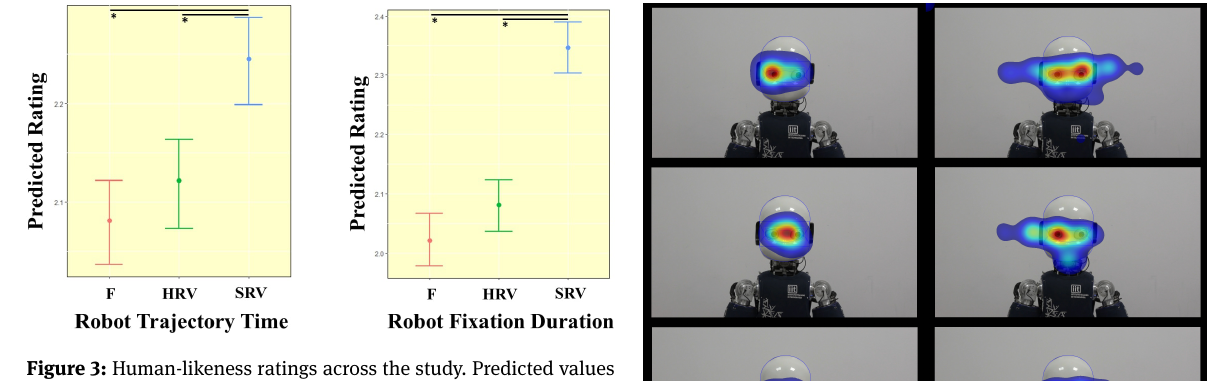
Figure 3: Human-likeness ratings across the study. Predicted values are plotted on the y-axes in order to facilitate the interpretation of re- sults.Verticalbarsdenote+/-1standarderror.Horizontalbarsdenote differences surviving post hoc comparison. Figure on the left shows Robot’s Trajectory Time (rTT) main effect on participants’ ratings (F: Mean=2.08, S.D.=1.30; HRV: Mean=2.12., S.D.=1.29; SRV: Mean=2.25, S.D.=1.32). Figure on the right shows Robot’s Fixation Duration (rFD) main effects on participants’ ratings (F: Mean=2.02, S.D.=1.12; HRV: Mean=2.08., S.D.=1.35; SRV: Mean=2.35, S.D.=1.33). Table 2: Z ratio and p values resulting from the post hoc comparisons for the human-likeness ratings; asterisks denote the significant re- sults.